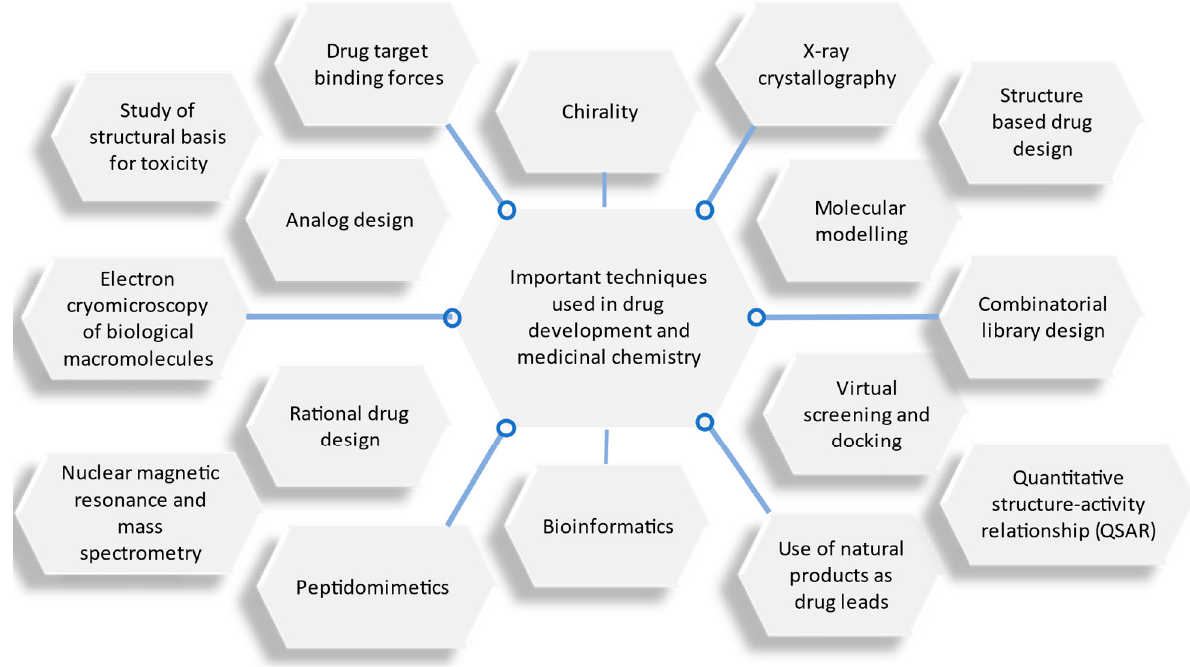
Figure 1. Various techniques used in drug discovery.